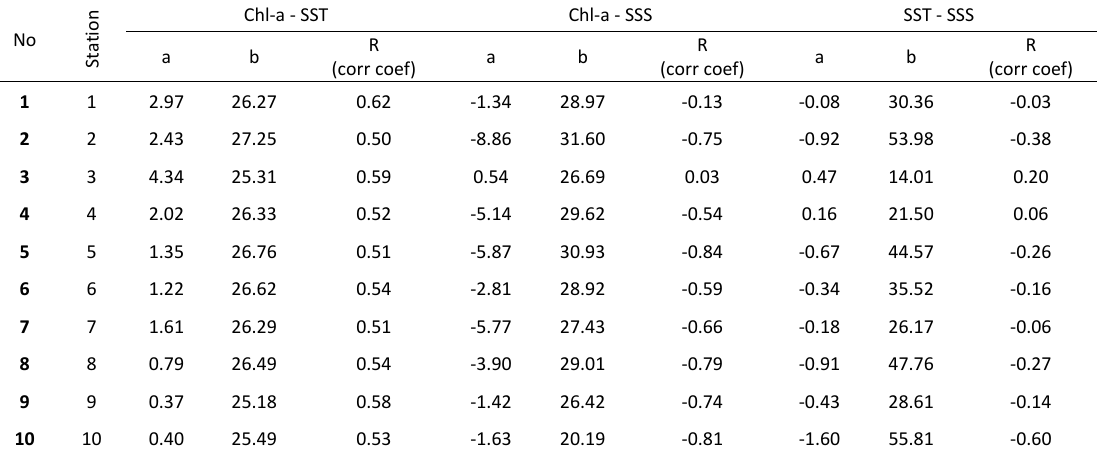
Table 4: Statistical data of all the variables